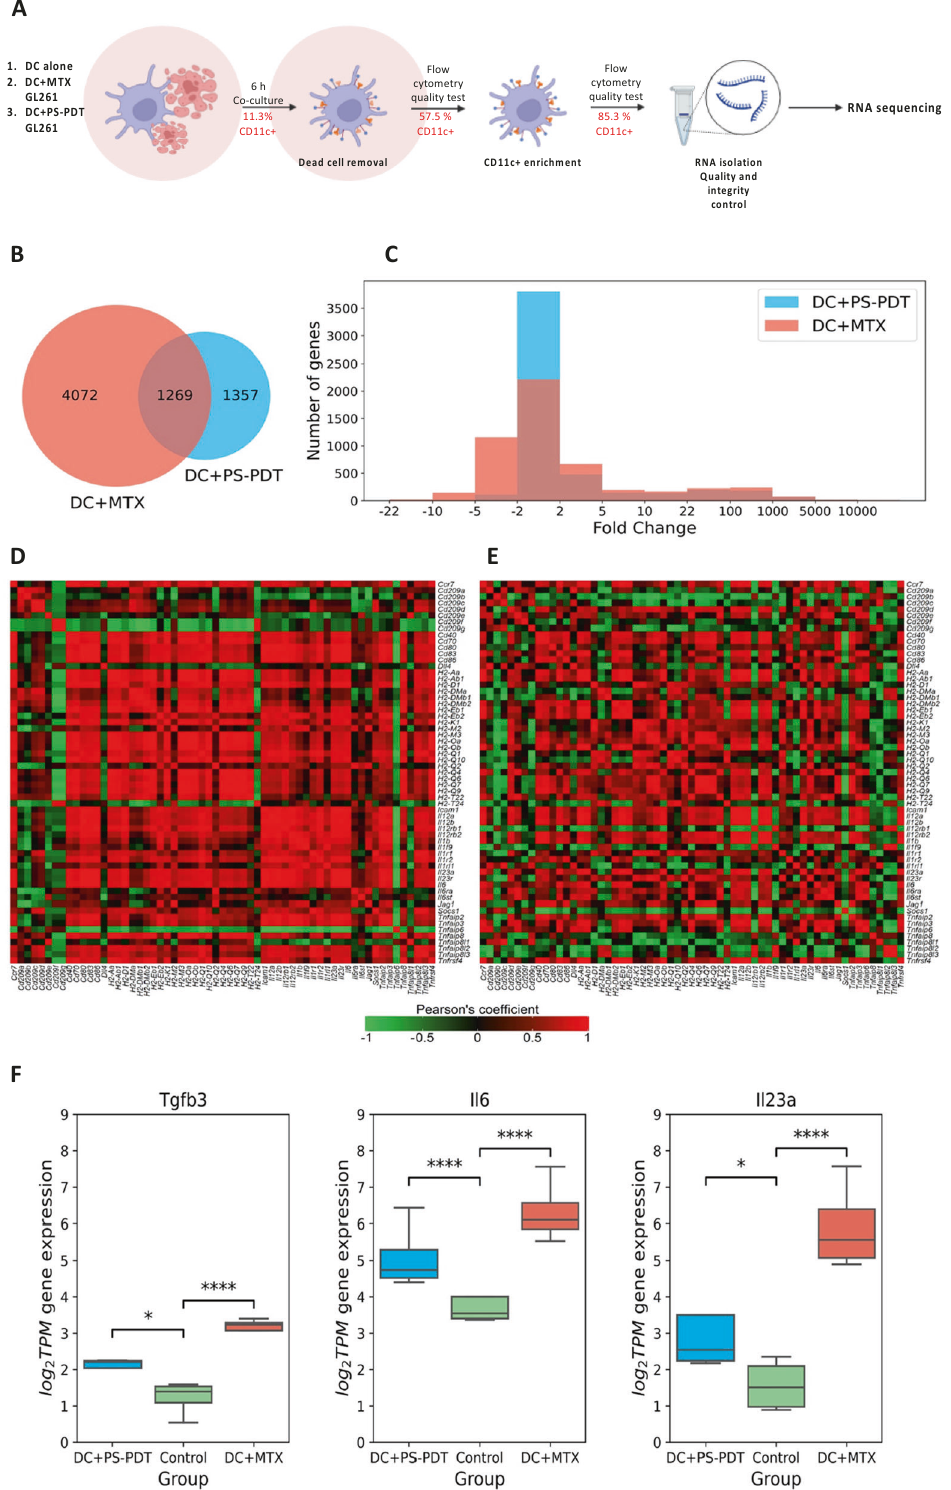
the TCGA-LGG cohort, we calculated the prognostic impact of the expression of the Th17 metagene on overall patient survival, dividing patients into groups with low and high metagene expression by the 75th percentile. In addition, we calculated the percent difference in median survival (% Δ MS ) between the high- expression and low-expression groups. Though the difference